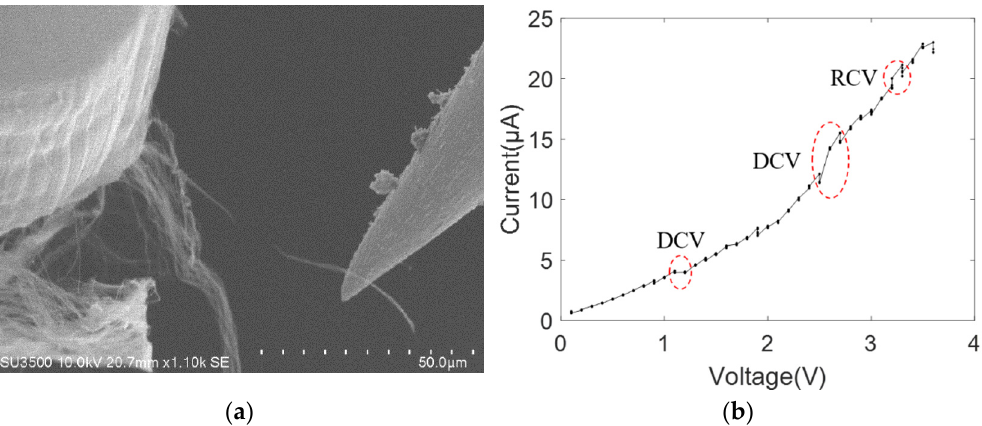
Figure 6. MWCNT bundle contacting with one platinum-coated tungsten probe ( a ) SEM image; ( b ) current–voltage curve.